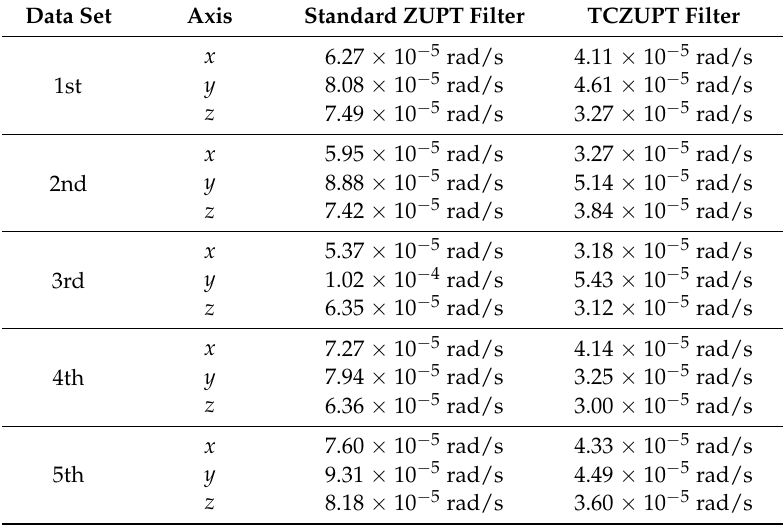
Table 10. Root Mean Squared Error (residual error of 15 degree/h, 5 data